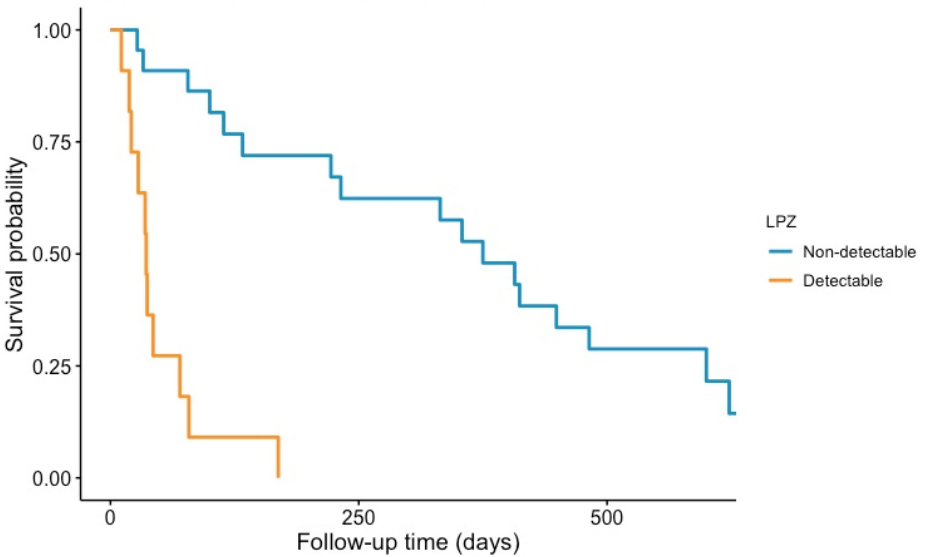
Figure 4. Kaplan–Meier plots for all-cause mortality in pre-transplant cirrhotic patients according to detectable plasma LP-Z concentrations. Log-rank test p < 0.001.